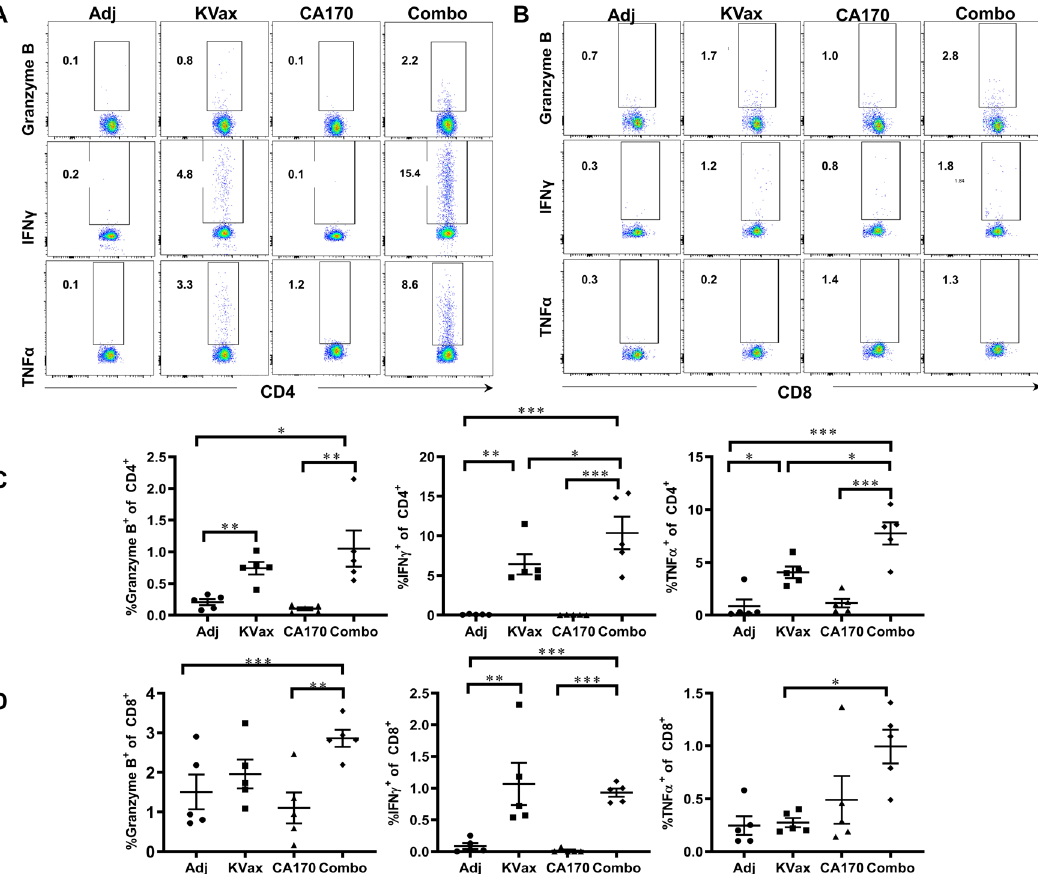
Fig. 4 CA170 treatment enhances intracellular cytokine levels induced by Kvax in CD4 + and CD8 + T cells from lung tumors. Lung tumors were processed into single cells at the endpoint of the experiment and fl ow cytometric analysis was conducted after stimulation with Kras peptide in the presence of monesin and brefeldin A. A , B Flow cytometric dot plots and C , D corresponding graphs depicting the amounts of cytokines granzyme B, IFN γ and TNF α measured by intracellular cytokine staining. Data are shown as the mean ± SE, n = 5, * P ≤ 0.05, ** P ≤ 0.01, *** P ≤ 0.001 vs